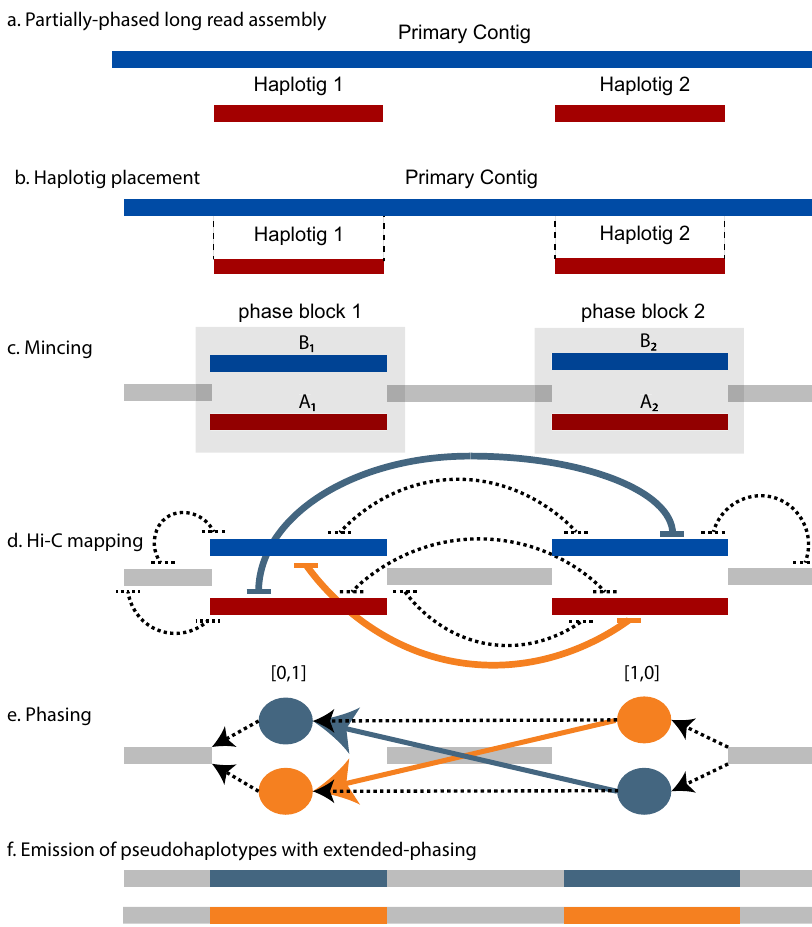
Fig. 1 Overview of FALCON-Phase method. a Partially phased long-read assembly consists of primary contigs (blue) and shorter alternate haplotigs (red). The region where a haplotig overlaps a primary contig is a phase block and is referred to as being unzipped because two haplotypes are resolved. Regions of the primary contig without associated haplotigs are referred to as collapsed because the haplotypes have low or no heterozygosity. b A haplotig placement fi le speci fi es primary contig coordinates where the haplotigs align. c This placement fi le is used to mince the primary contigs at the haplotig alignment start and end coordinates. Mincing de fi nes the phase blocks (A – B haplotype pairs, blue and red) and collapsed haplotypes (gray). d Hi-C read pairs are mapped to the minced contigs and alignments are fi ltered to retain haplotype-speci fi c mapping. e Phase blocks are assigned to state 0 or 1 using the phasing algorithm. f The output of FALCON-Phase is two full-length pseudo-haplotypes for phase 0 and 1. These sequences are of similar length to the original primary contig and the unzipped haplotypes are in phase with each other. Table 1 Input statistics for the genomes used for FALCON-Phase. Sample